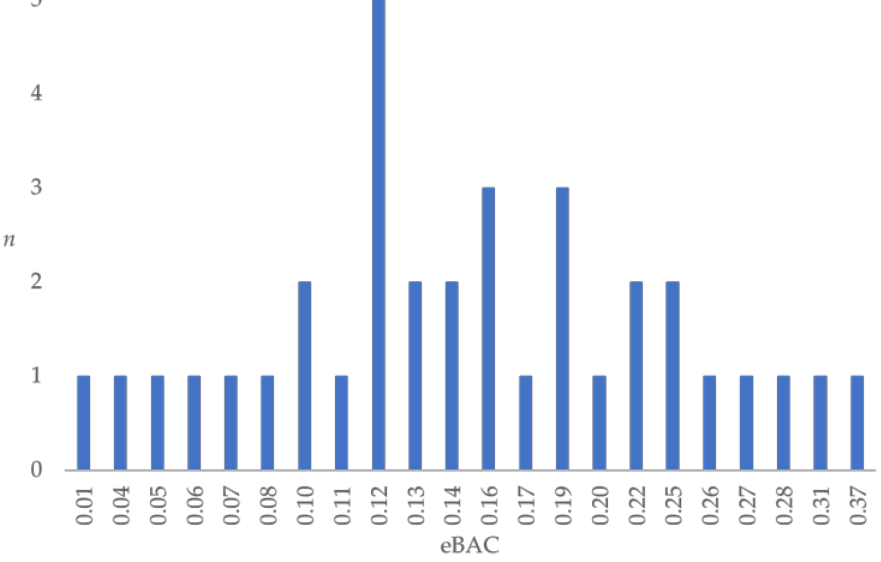
Figure 2. A visual representation of the range of eBAC values during the drinking episode preceding the hangover condition and number of participants experiencing each eBAC